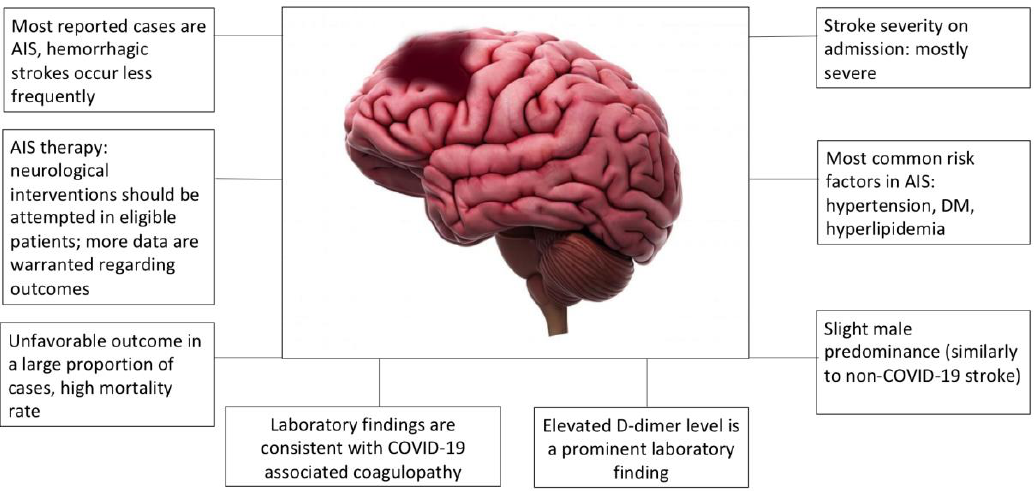
Figure 3. Common features of COVID-19-associated stroke. AIS, acute ischemic stroke; DM, diabetes mellitus.